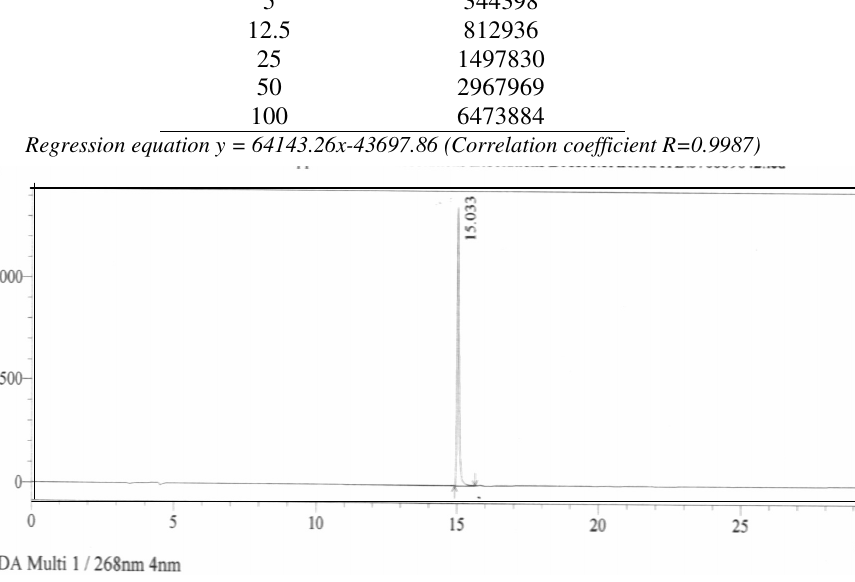
Figure 1 .Typical chromatogram of cinitapride